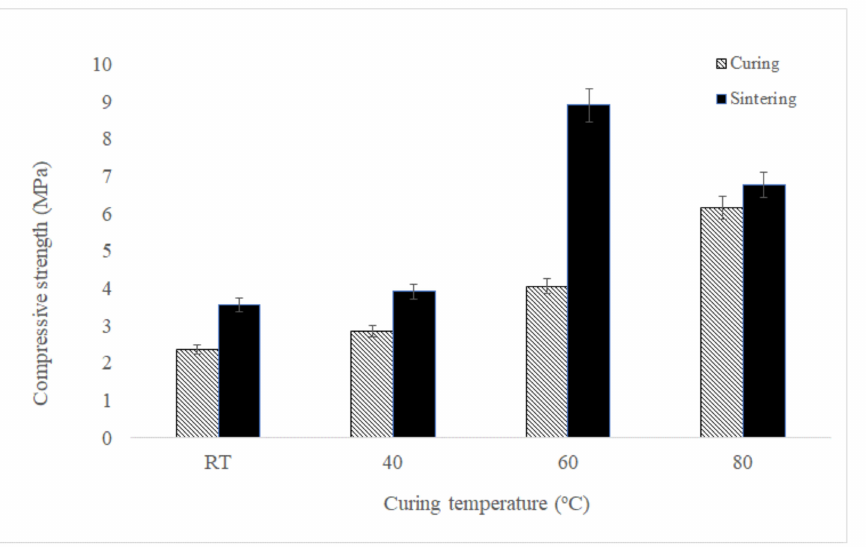
Figure 7. Effect of curing temperature on the compressive strength of cured and sintered kaolin-GGBS geopolymer